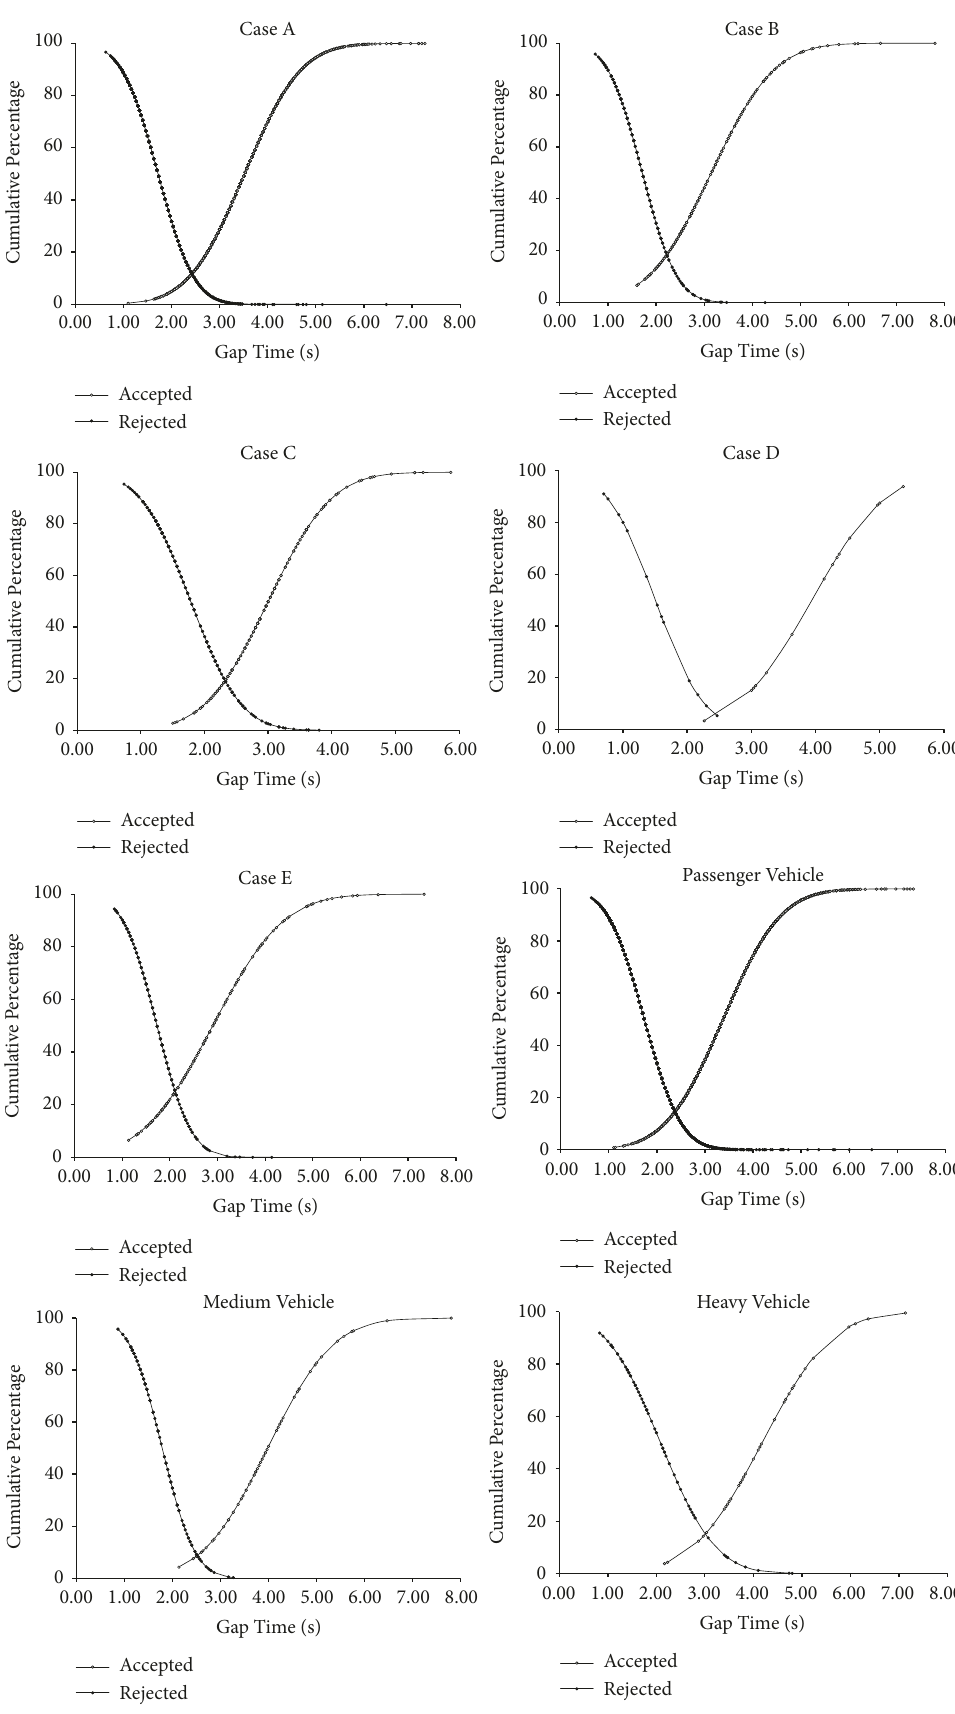
Figure 7: Critical gap for different